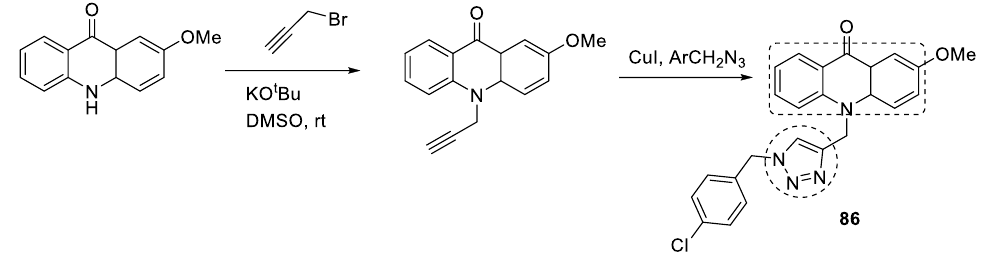
Figure 30. Chemical structure of acridone – 1,2,3-triazole hybrid.